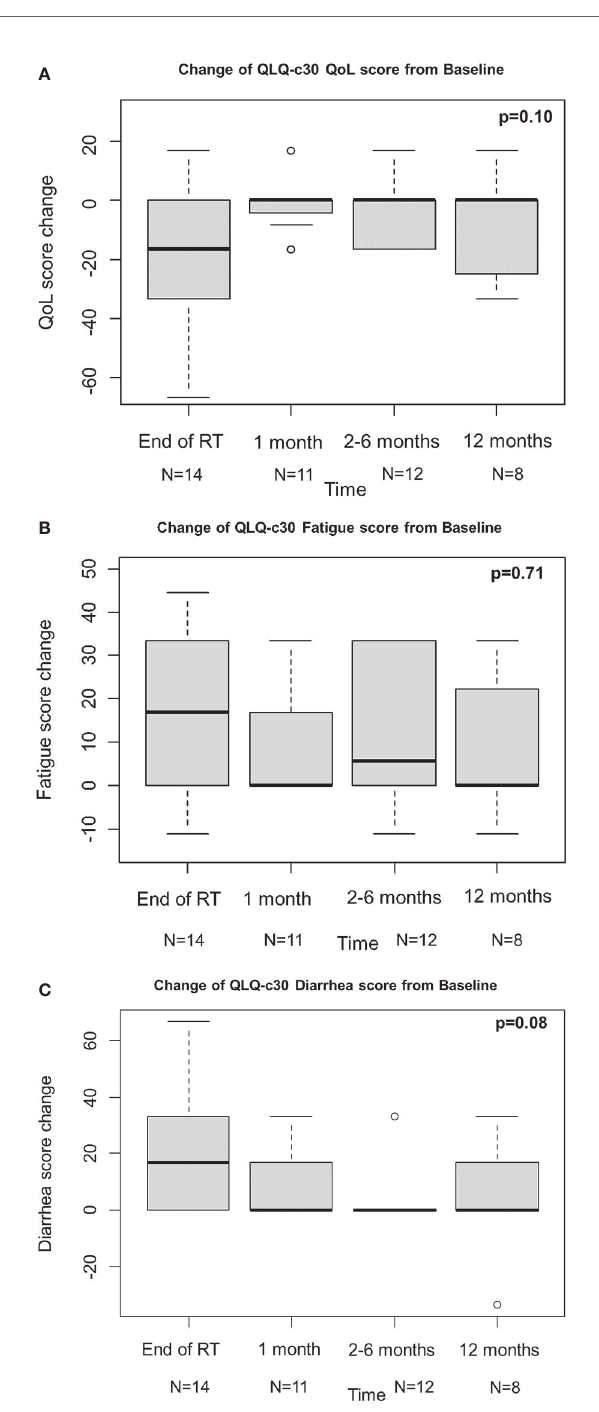
FIGURE 1 | Change of QLQ-c30 QoL score (A) , fatigue score (B) , diarrhea score (C) from baseline.